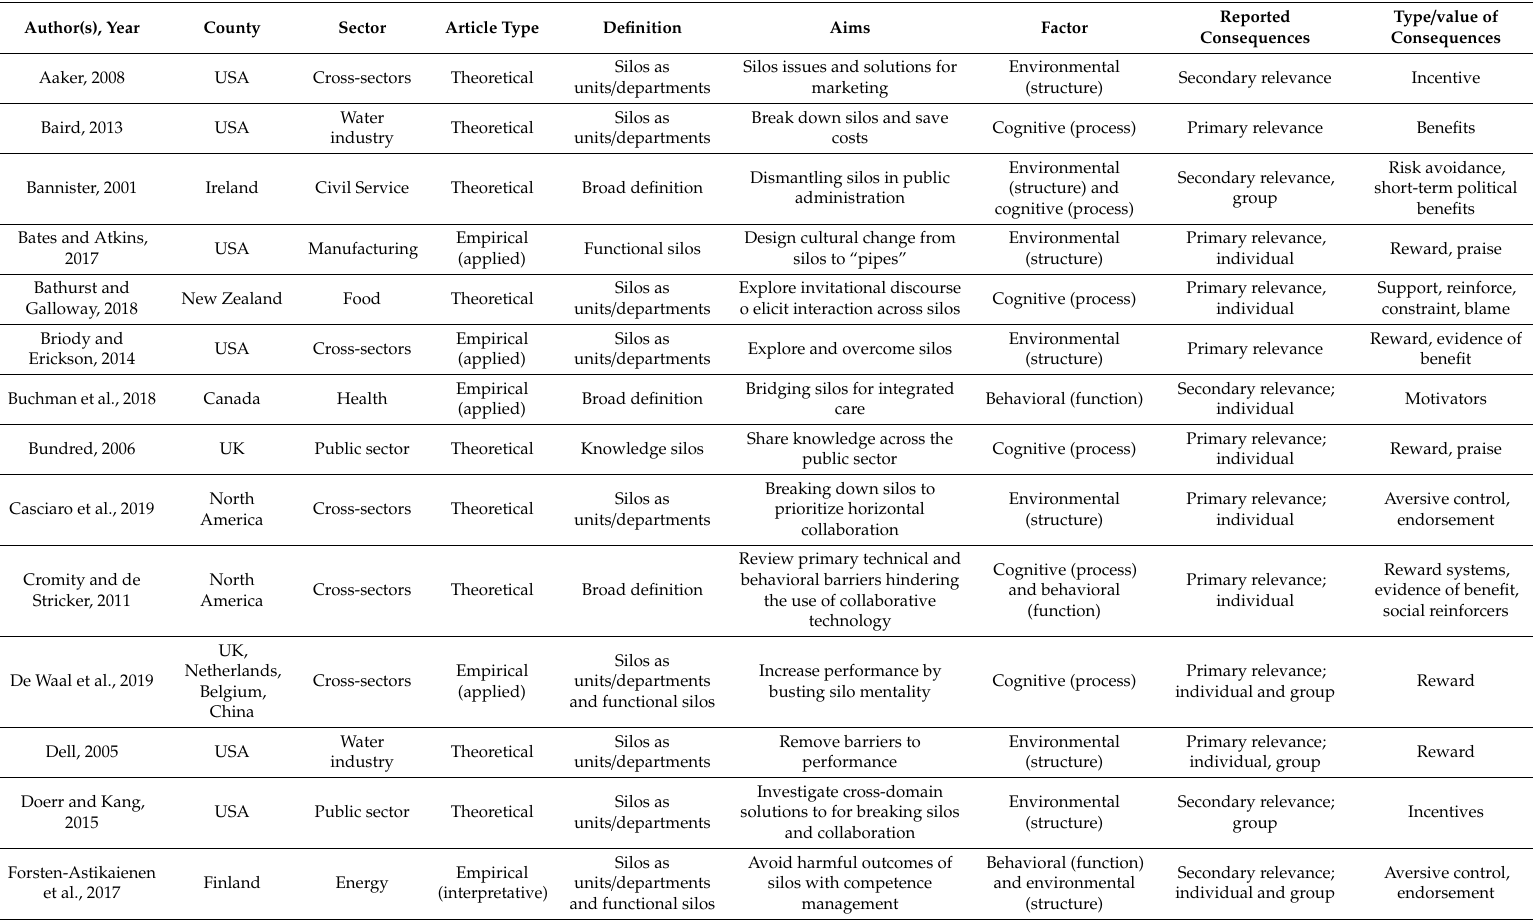
Table 1. Overview of included articles with a qualitative account of silos in organizations. For each study, general information, operationalization of the concept and aims are